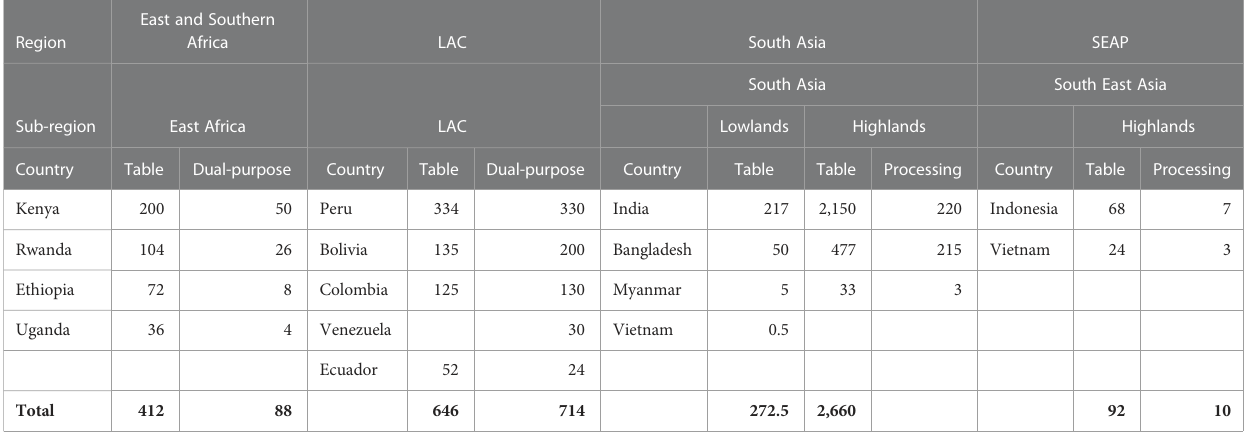
TABLE 2 Hectares targeted in the potato market segments.